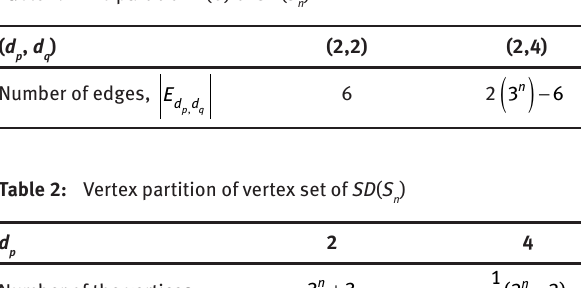
Figure 1: Uniform subdivision of Sierpiński gasket graph SD ( S SD ( S ), and SD ( S 2 Table 1: The partition E ( G ) of SD ( S